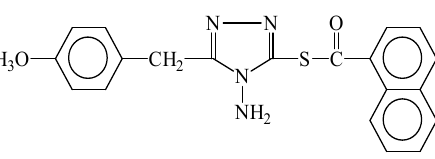
Figure 1. Structure of Compound ( 6a ).